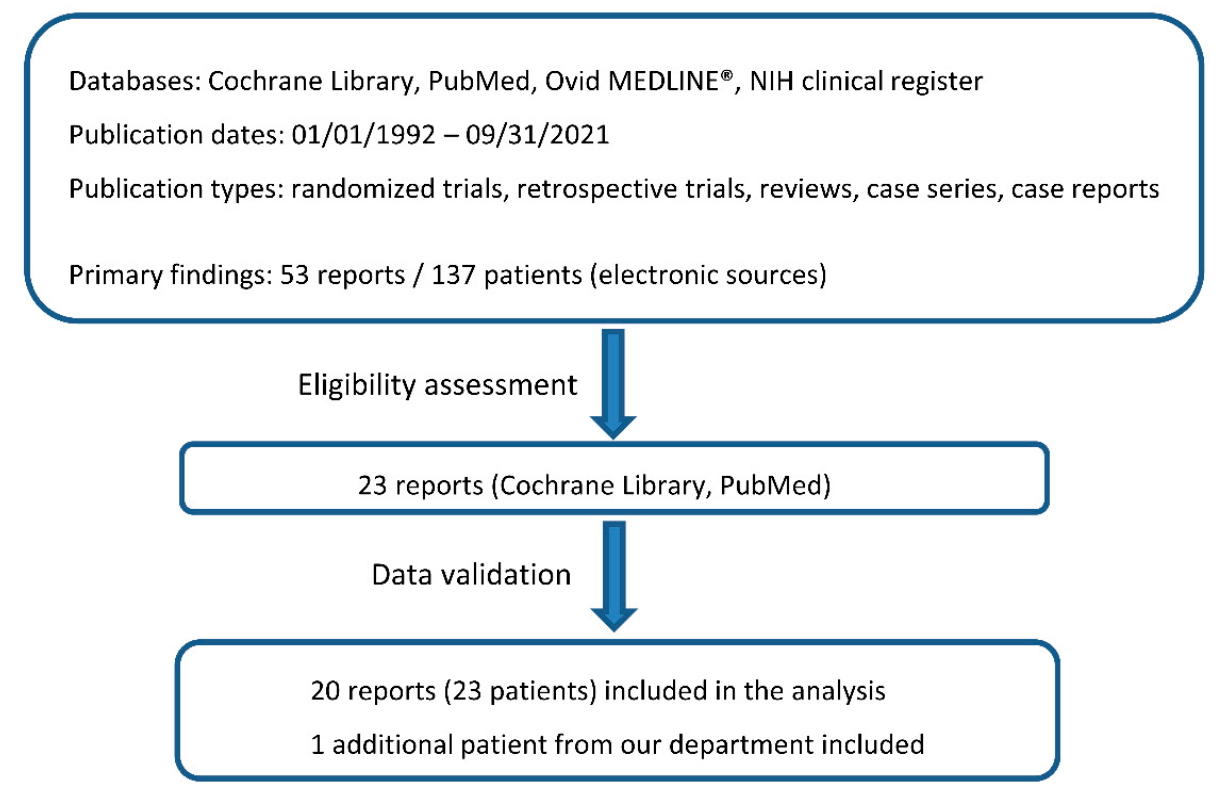
Figure 1. Flow chart of the report selection process. The database resources included: Cochrane Library, PubMed, Ovid MEDLINE Research platforms, and the NIH clinical trials register (https://clinicaltrials.gov/) (accessed on 4 October 2021). The following search terms were used: Ewing Sarcoma, peripheral neuroectodermal tumor, thoracal spine, lumbar spine, intraspinal Ewing sarcoma, cranio-spinal irradiation.